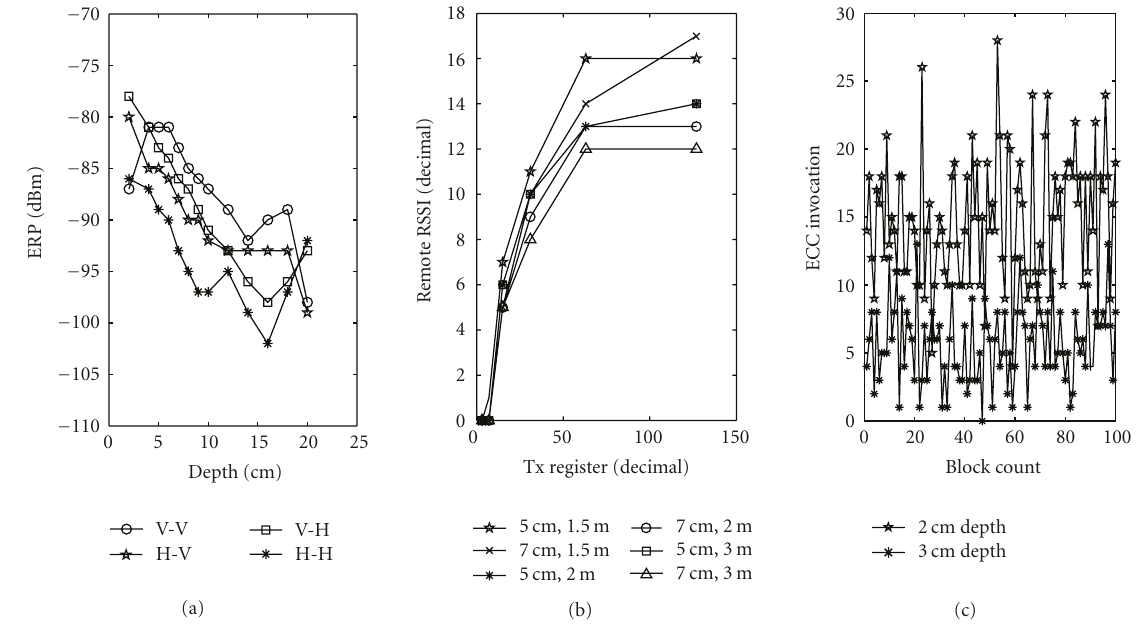
Figure 1: (a): ERP versus Depth, (b): RSSI versus Base station power (in decimal), (c): ECC innovation versus 100 blocks of data.